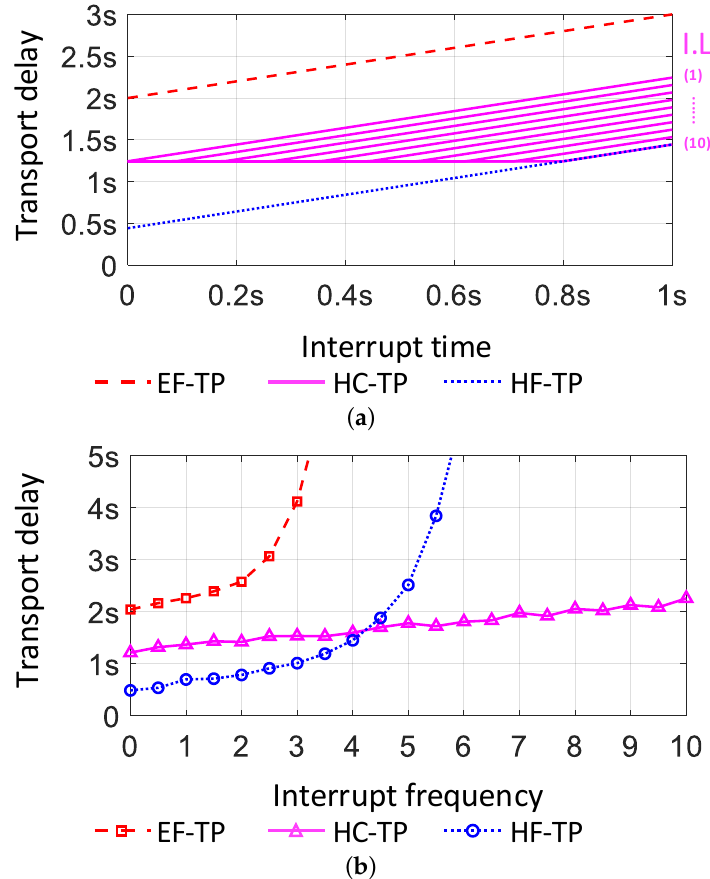
Figure 11. Transport progress in temporary route interruption. ( a ) Transport delay in single interruption. ( b ) Transport delay in continuous